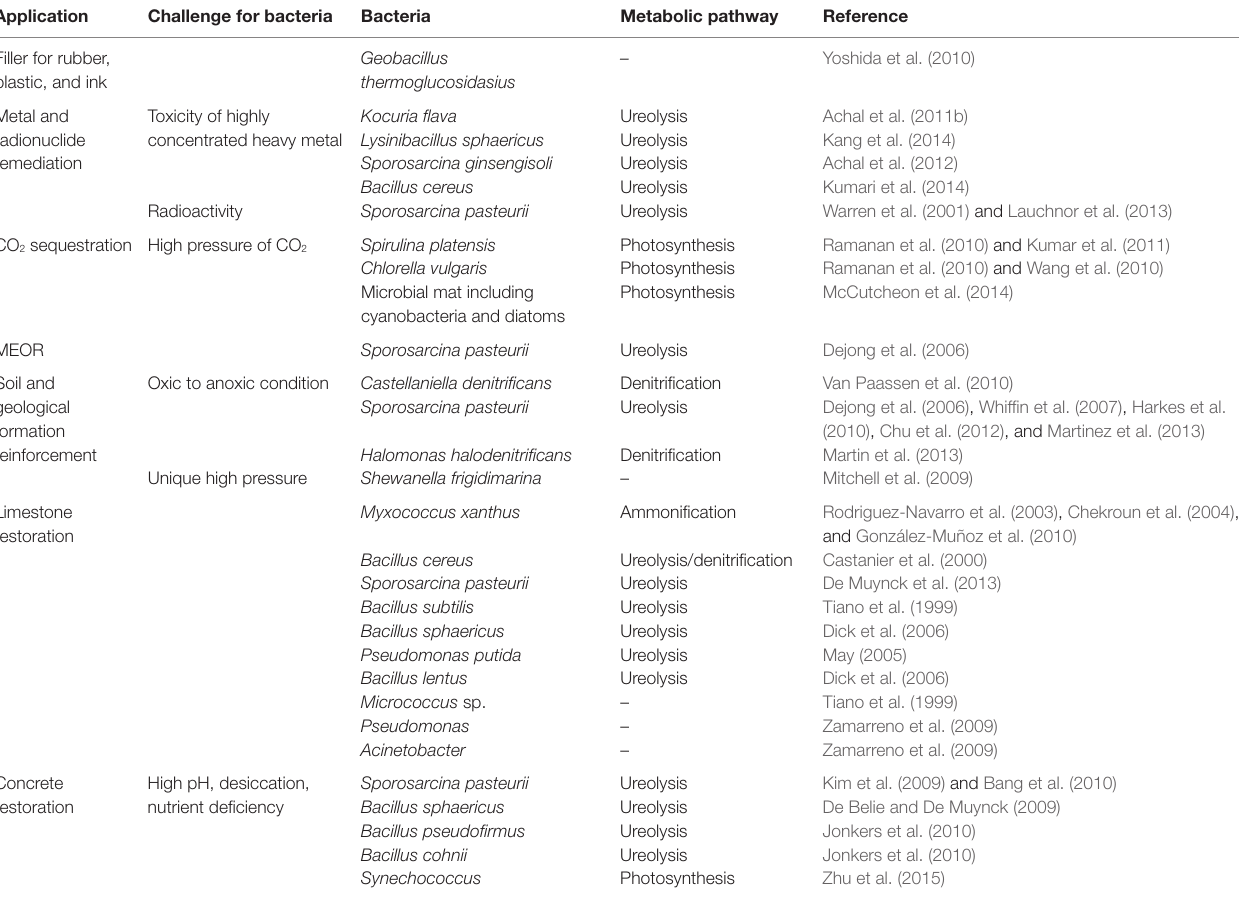
TABLe 2 | Bacterial species, their metabolic pathways, and possible challenges faced by them in different industrial